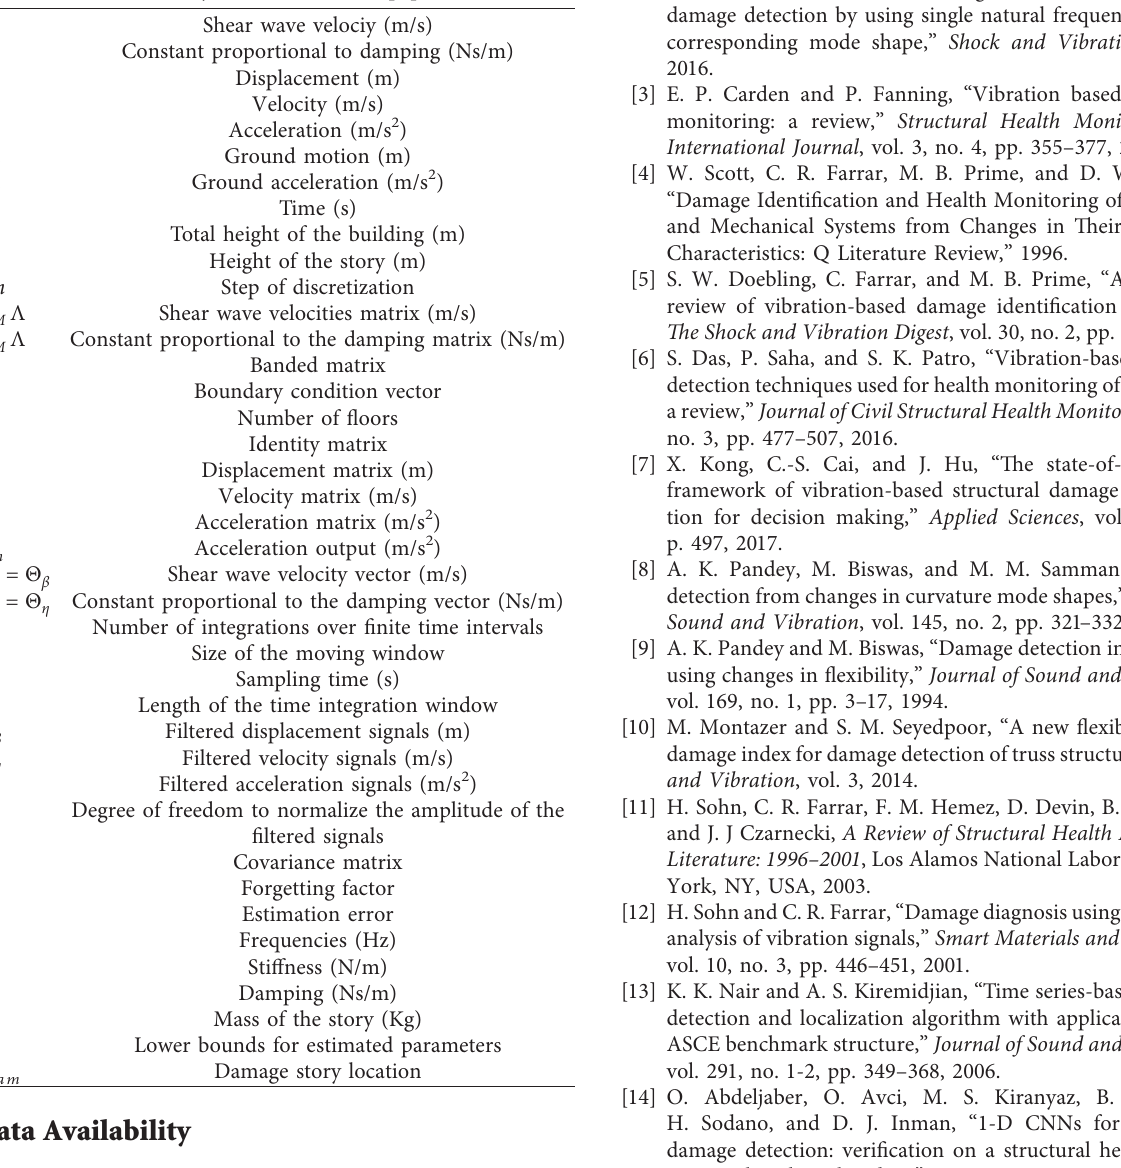
Table 7: Symbols used in this